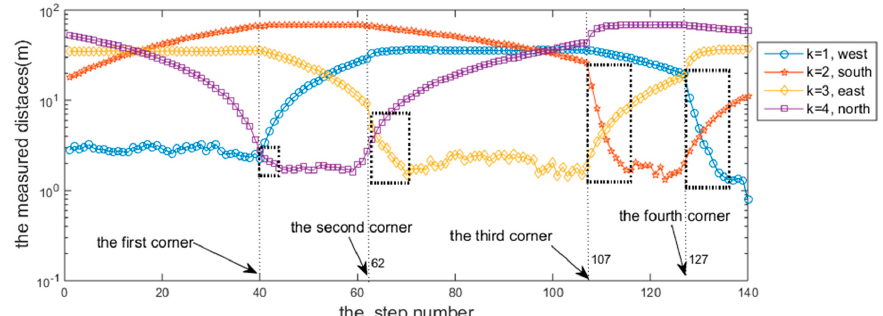
Figure 7. Illustration of the trend diagram of r mt , k .